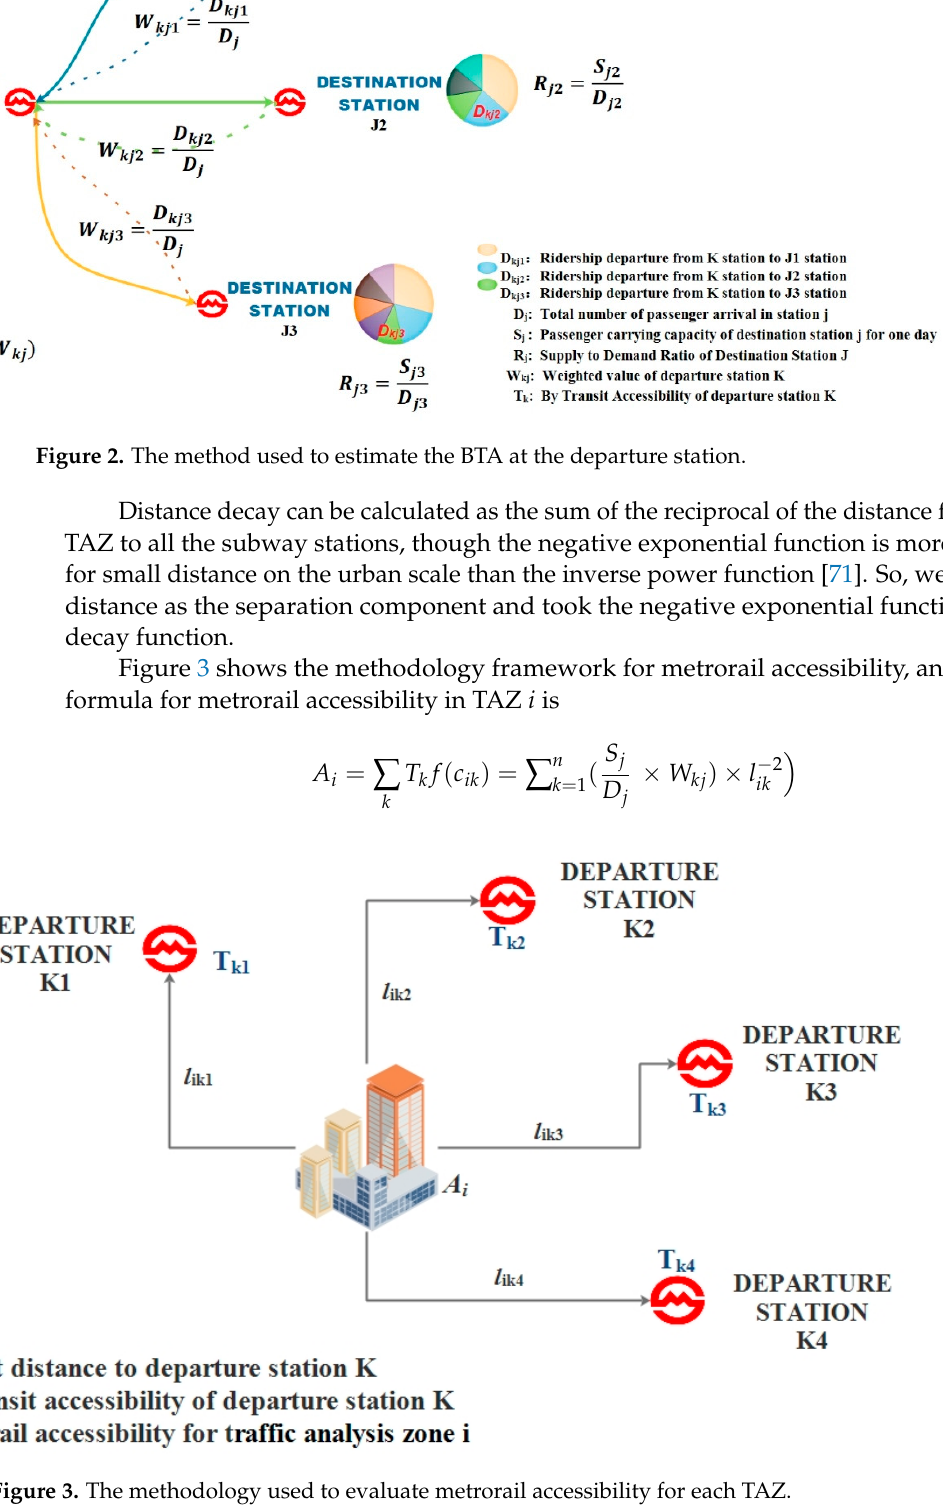
Figure 3. The methodology used to evaluate metrorail accessibility for each TAZ.